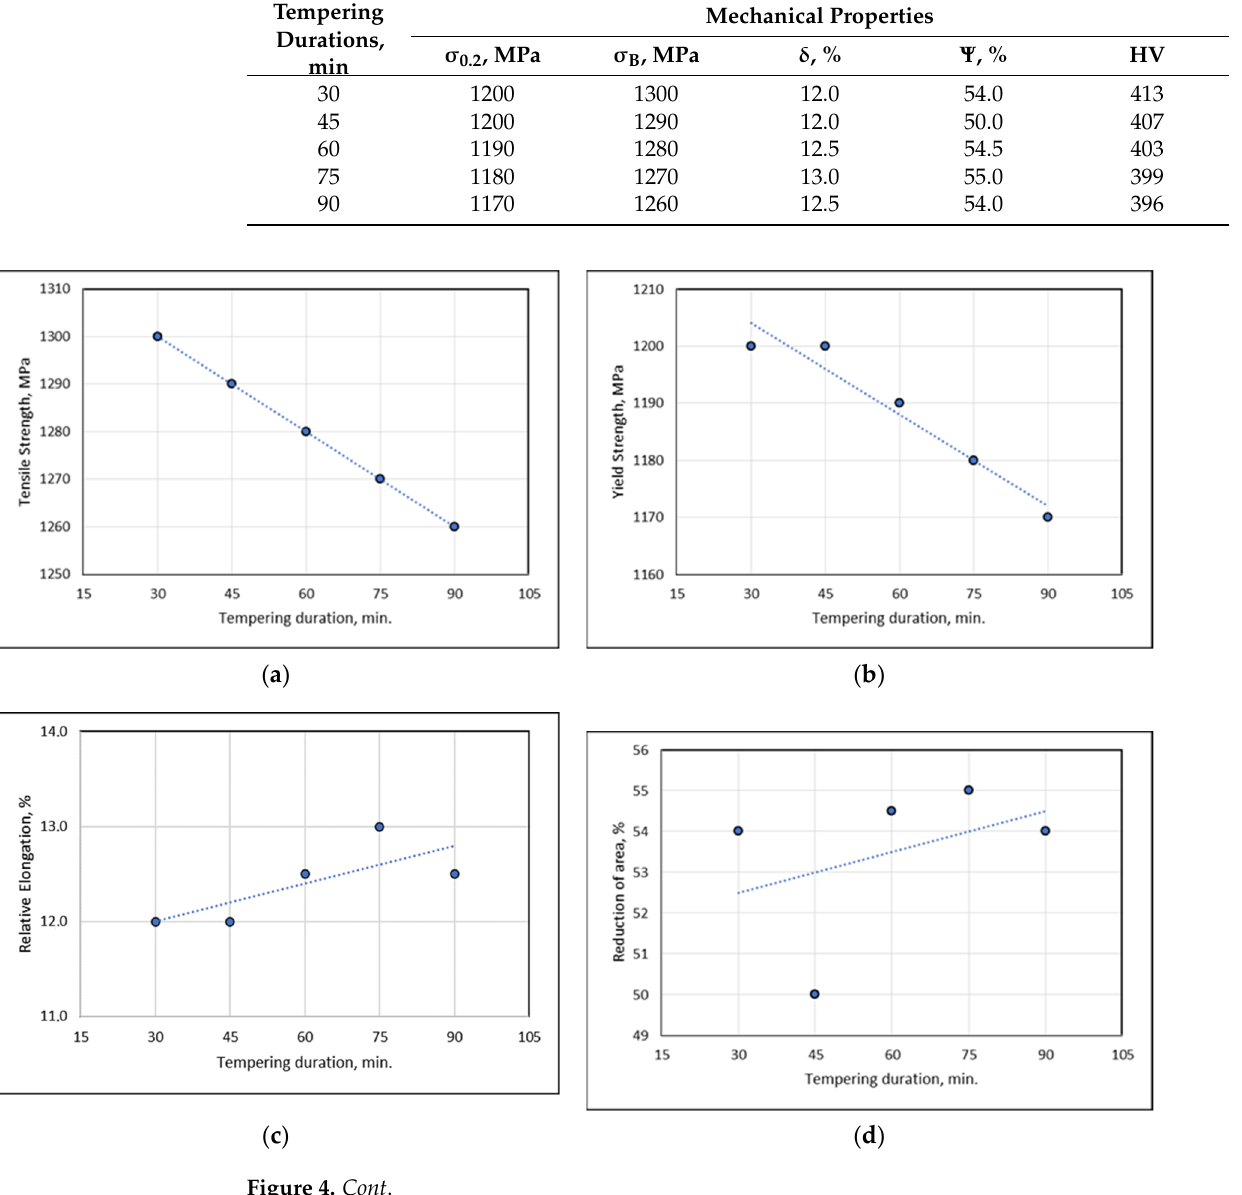
( e ) Figure 4. Dependences of mechanical properties of rolled products from 42CrMo4 grade steel on the duration of tempering at 500 °C: ( a ) tensile strength; ( b ) yield strength; ( c ) relative elongation; ( d ) reduction in area; and ( e ) microhardness HV. From the data in Table 4 and Figure 4, it follows that in the entire investigated tem- pering time interval at a temperature of 500 °C, the required mechanical properties for property class 12.9 are achieved. However, it should be noted that with a tempering du- ration of 45 min, a decrease in the reduction in area value was detected. Since, when tem- pering for 60–90 min is used at the studied temperature, the necessary strength properties are achieved, and the plasticity of the metal increases slightly, it is advisable to use the duration of tempering in this range.